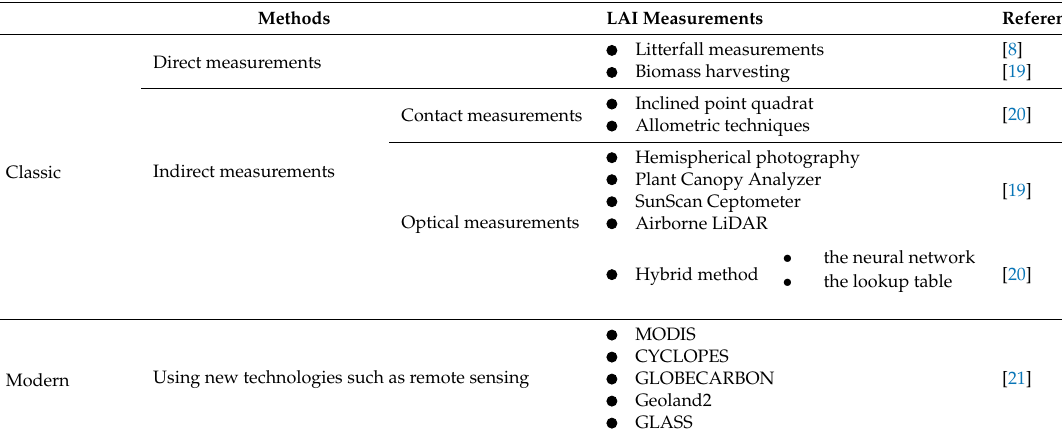
Table 1. Summary of types of LAI measurement